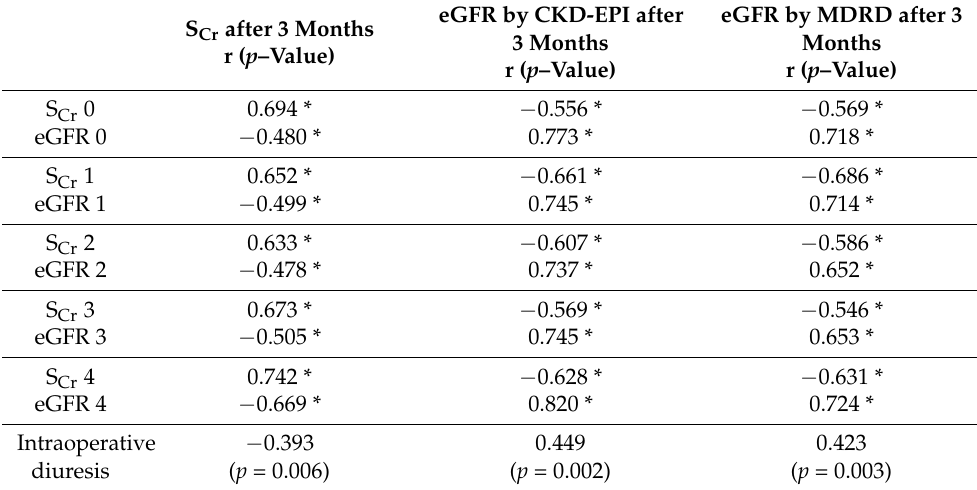
Table 4. Relationship between perioperative and long-term kidney function. Spearman rank correla- tion coefficients are presented together with statistical